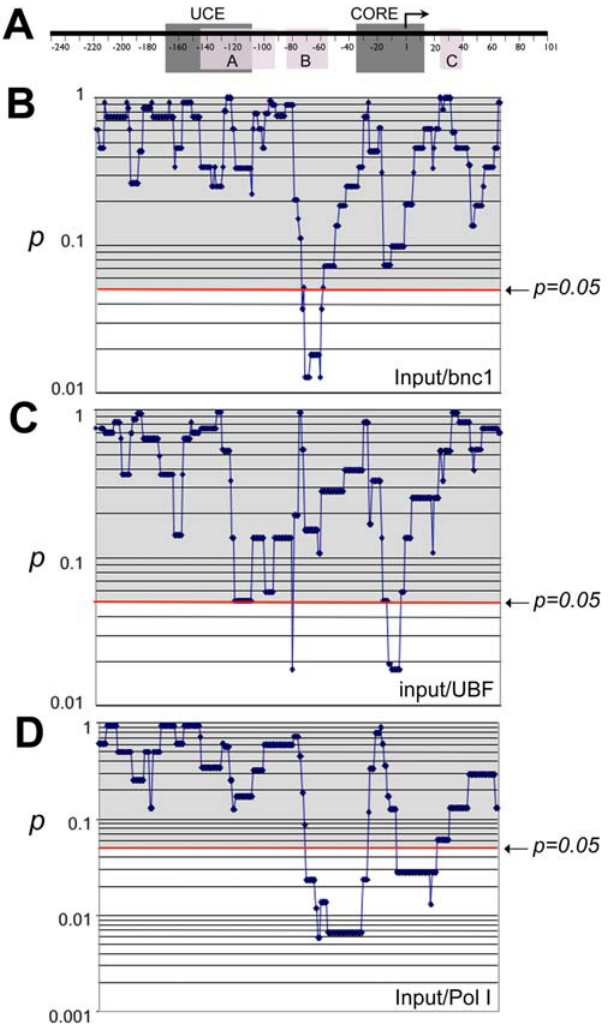
Figure 7. A statistical pair-wise comparison of local SNP frequency between the randomly picked genomic rDNA promoter and the promoters associated with basonuclin, UBF, or RPA194. A , a generic rDNA promoter, to which all the other panels ( B, C, D ) are aligned. The notations on the rDNA promoter are as described in Fig. 5A . In panel B, C, D , p values were calculated by a chi-square test and plotted. The notation and graphic depictions are as described in Fig. 5B . B , input vs. basonuclin, C , input vs. UBF, D , input vs. RPA194.